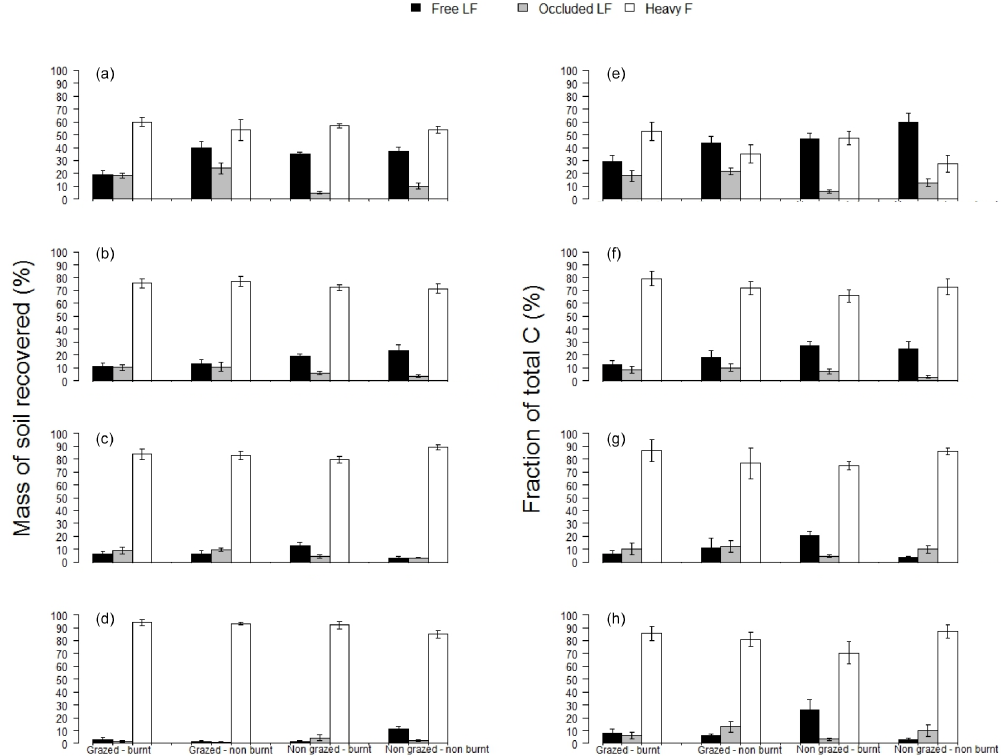
Figure 5. Mass of soil recovered in the three density fractions (%) on the four left bar plots and the proportion of total C residing in the three density fractions (%) on the four right bar plots for the different land uses ( a = 0–5, b = 5–10, c = 10–20, d = 20–30cm). Error bars indicate 1 standard error of the mean ( n =